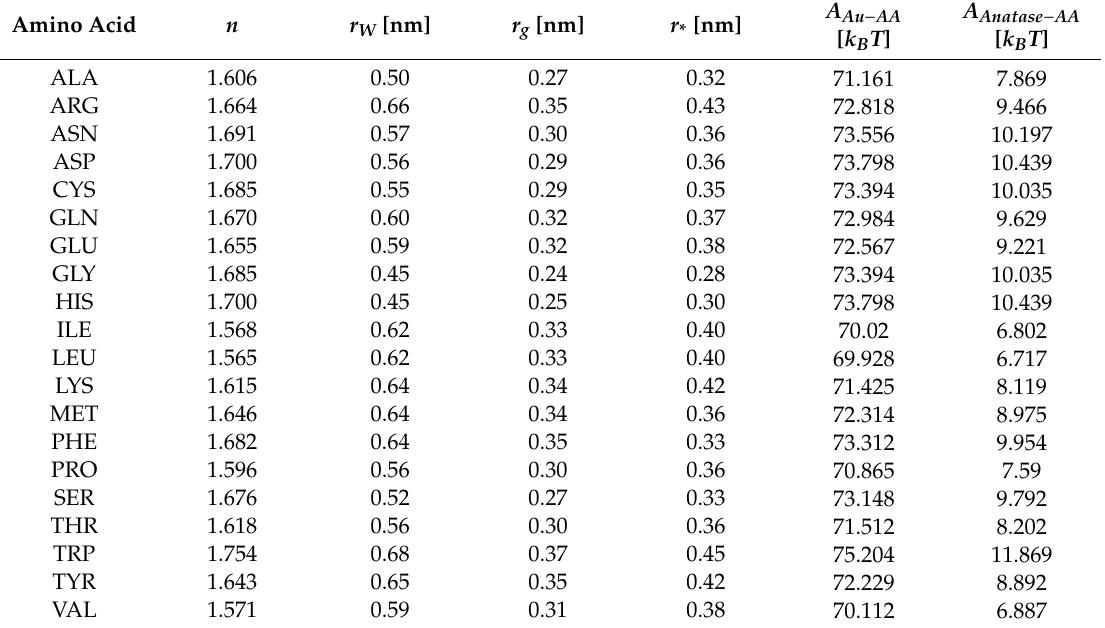
Table A1. Tabulation of AA properties relevant to this work. r ∗ are the optimal AA radii from Equation